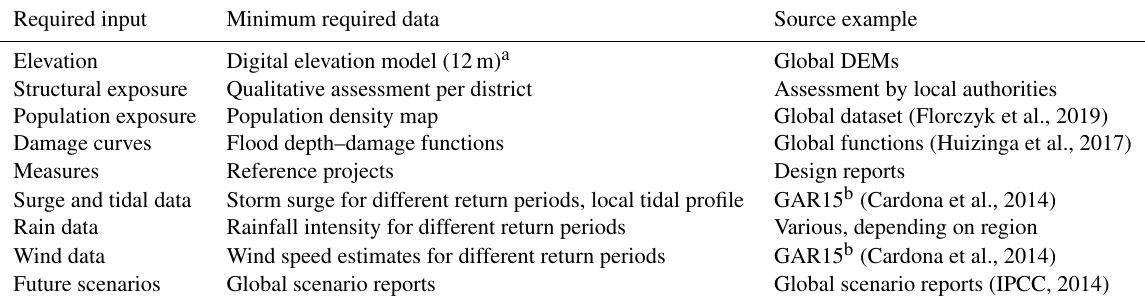
Table 1. Minimum requirements for FLORES data sources.